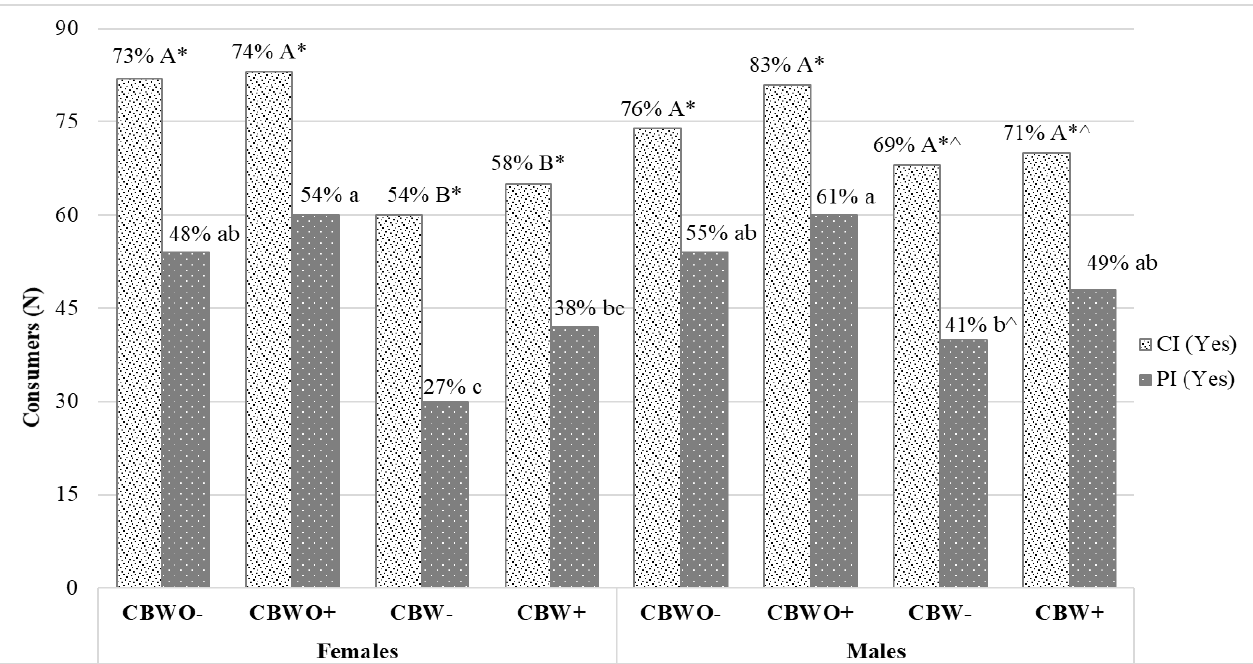
Figure 5. Gender’s consumption intent and purchase intent plot across treatments † . Data are frequencies of “Yes” responses per treatment from n = 112 female and n = 98 male consumers analyzed by Cochran’s Q test with asymptotic McNemar test for post hoc multiple pairwise comparisons and p -value adjustment by false discovery rate. † Treatments are described in Figure 1. Uppercase/lowercase letters represent significantly ( p < 0.05) different consumption intent/purchase intent frequencies across treatments for each gender. * Significant ( p < 0.05) difference across purchase intent and consumption intent within treatments for each gender. ^ Significant ( p < 0.05) difference in consumption intent/purchase intent frequencies across genders (Z-test 2 population proportions) within treatments.